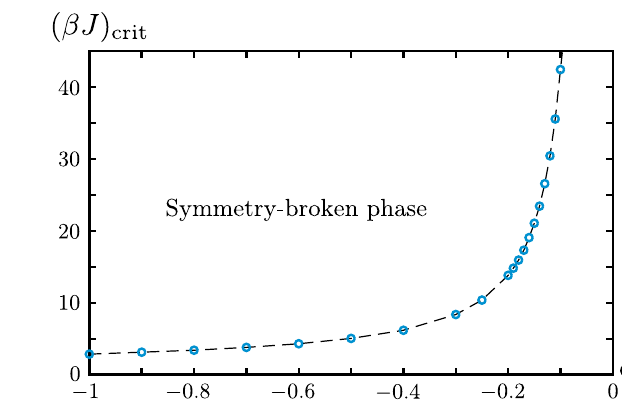
, i.e., j G 12 ð 0 Þj , as a SYK is shown. FIG. 11. Critical value of β J as a function of α crit